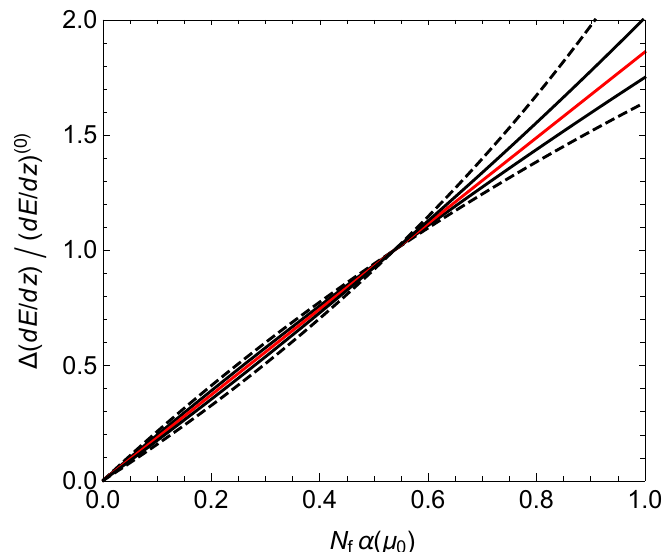
Figure 9 . Like (cid:12)gure 6 but here for the relative size (cid:1)( dE=dz ) = ( dE=dz ) (0) of NLO corrections to the electron energy loss